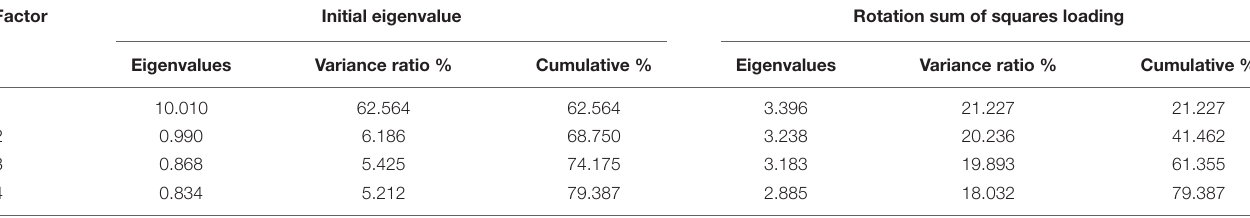
TABLE 4 | Total variance explained by the 4 factors.